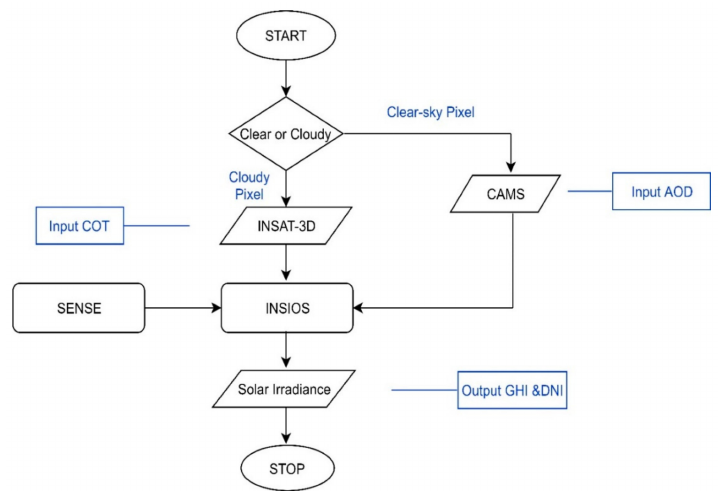
Figure 2. Flowchart of the Indian Solar Irradiance Operational System (INSIOS) technique. COT: cloud optical thickness, INSAT-3D: Indian National Satellite System, CAMS: Copernicus Atmosphere Monitoring Service, AOD: aerosol optical depth, SENSE: Solar Energy Nowcasting System (SENSE), GHI: global horizontal irradiance, DNI: direct normal irradiance.